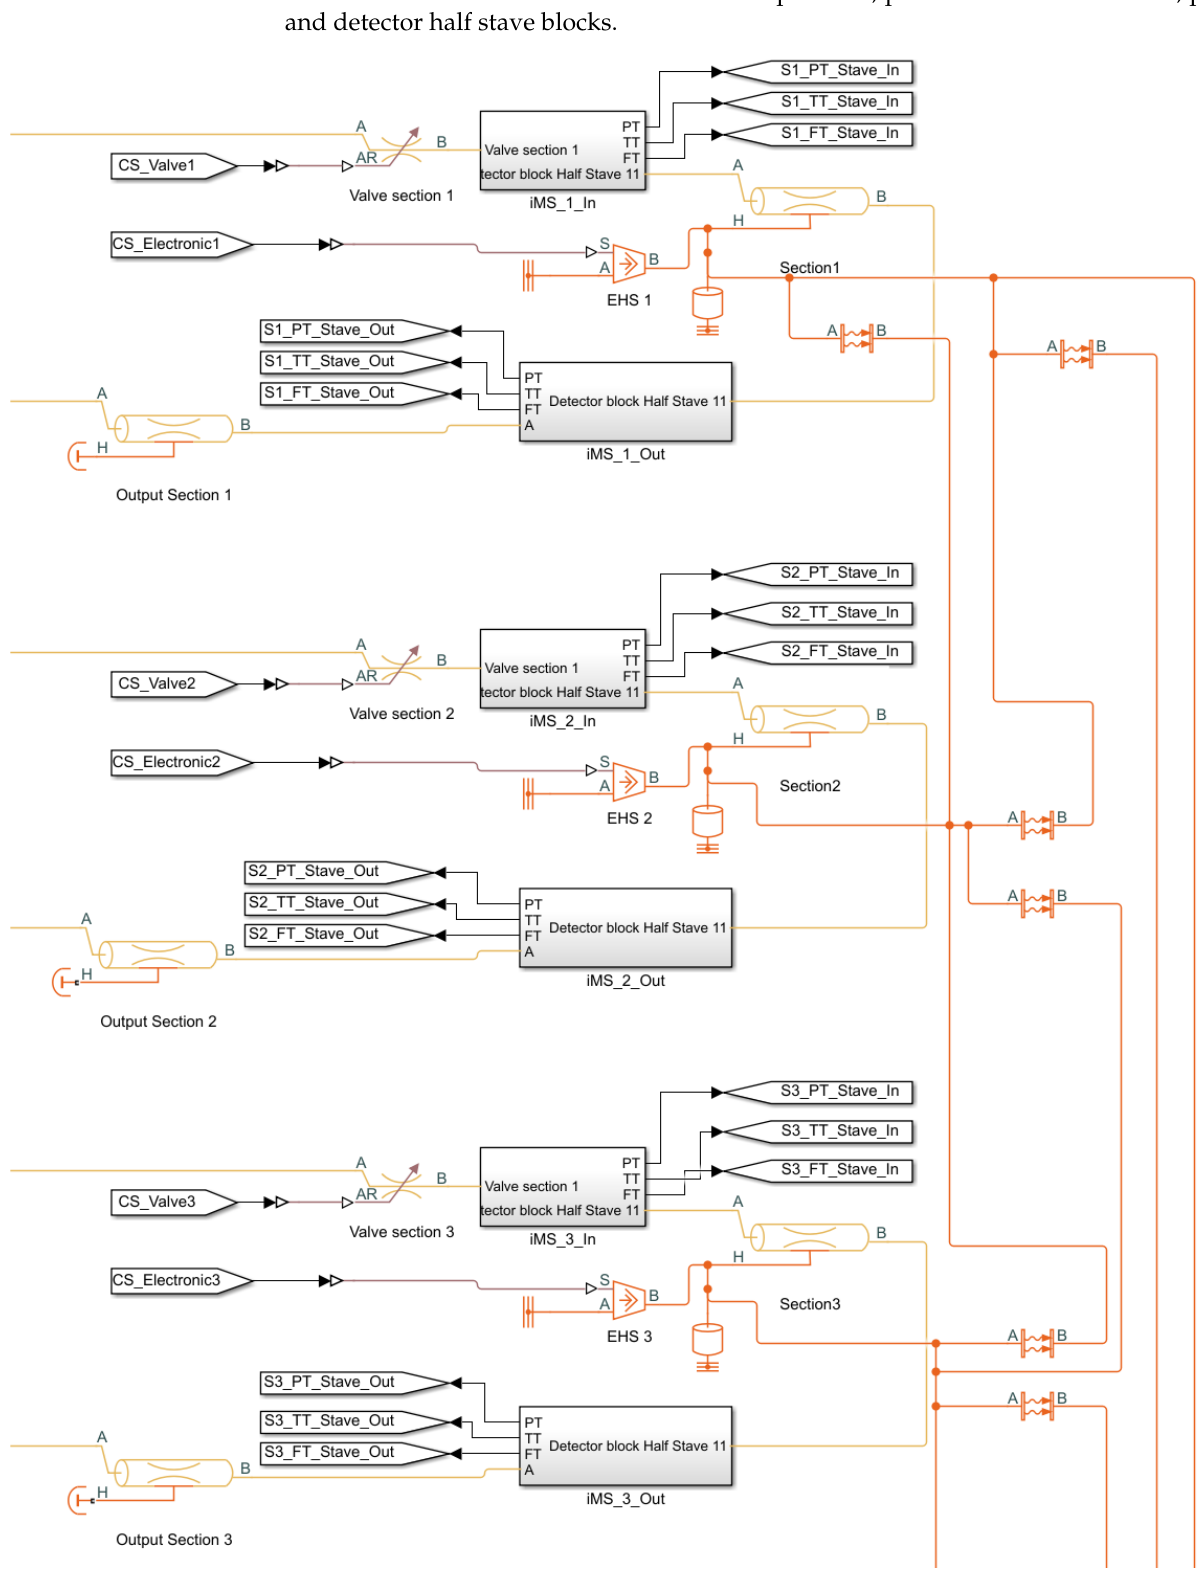
Figure 18. The alternative simple structure of